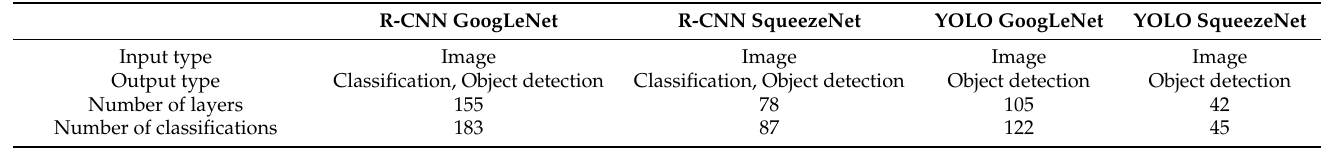
Table 2. The network architectures considered in the experimental part of the study.